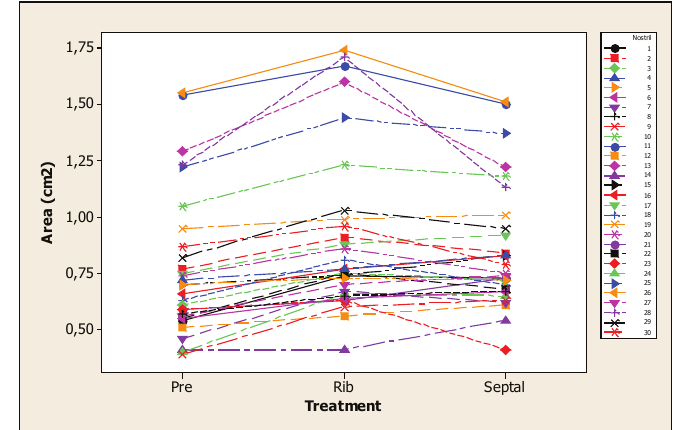
FIGURE 5 - Plot of the area values for each